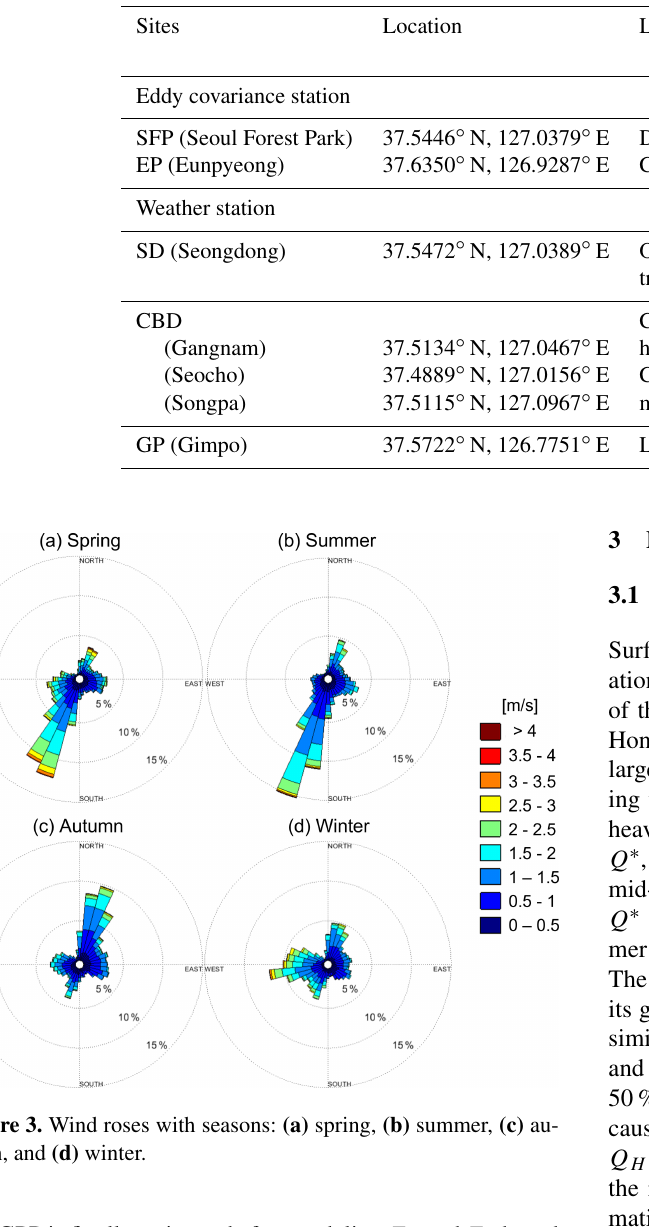
Table 1. Details of the stations used in this study.